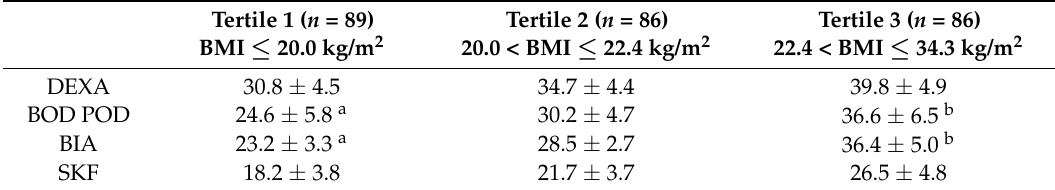
Table 3. Descriptive statistics of PBF separated by BMI tertiles for women.